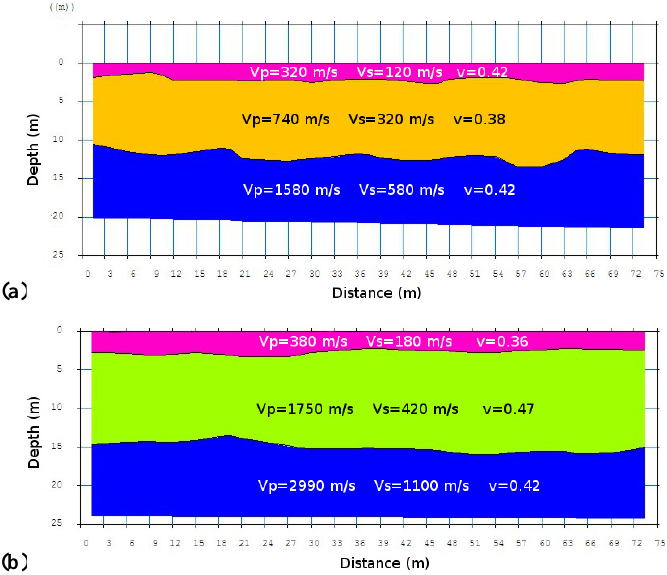
Fig. 5. The statigraphic models at the sites QQ 0 (a) and PP 0 (b) as resulted from seismic refraction surveys of P- and S-waves.